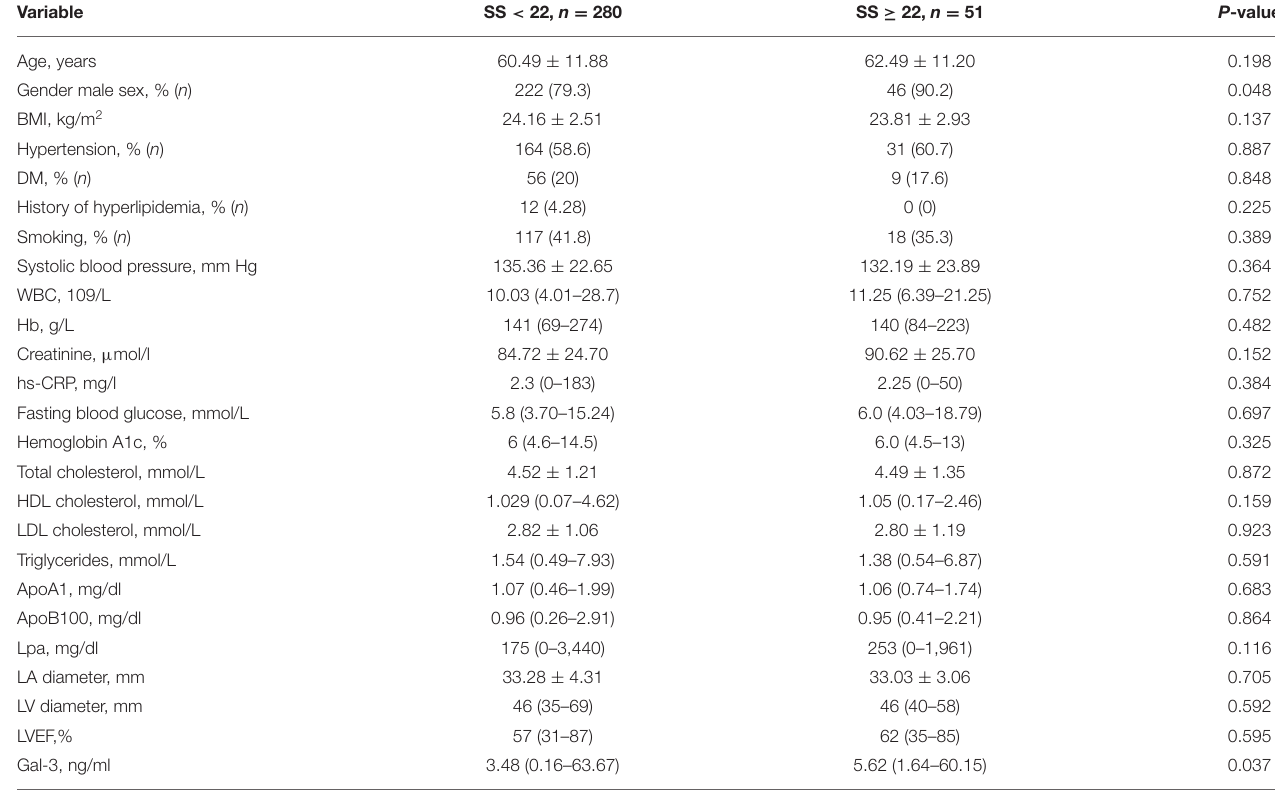
TABLE 5 | The baseline clinical and biochemical characteristics of the low SS group and High SS group.